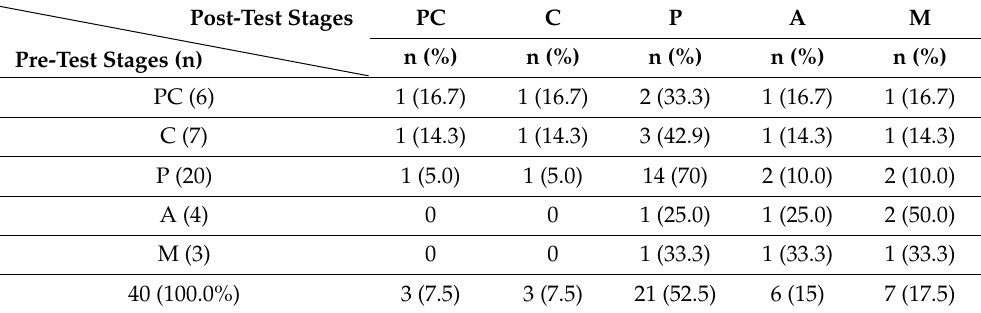
Table 4. The distribution of nurses relapsing and progressing between stages on pre-test and post-test (N = 40).